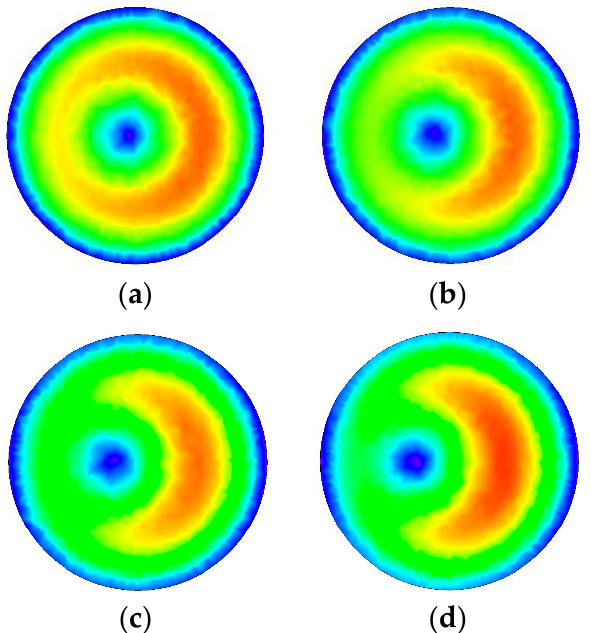
Figure 28. Distribution diagrams of magnetic field strength with the conventional structure and different offsets of the secondary coil. ( a ) 5 mm. ( b ) 10 mm. ( c ) 15 mm. ( d ) 20 mm.